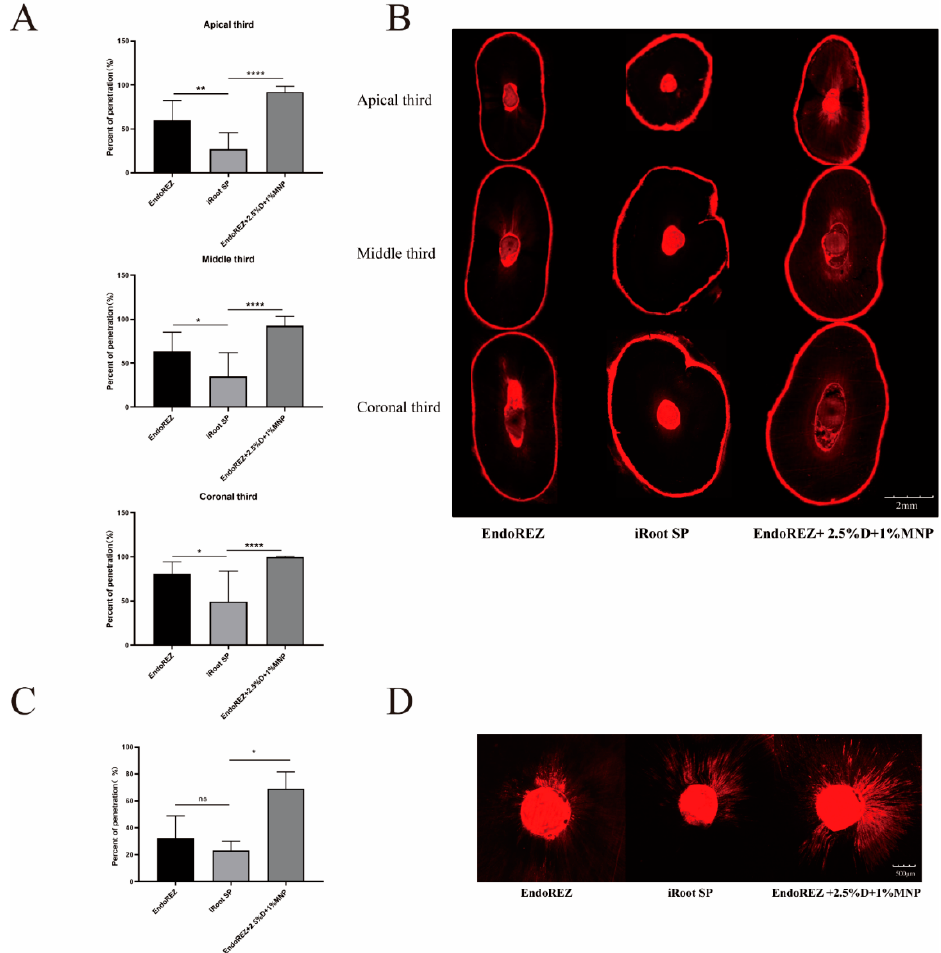
Figure 2. The dentinal tubule penetration of three sealers by CLSM. ( A ) Statistical analysis of dentinal tubule penetration in extracted human single-root maxillary premolars ( n = 10) (dentinal tubule penetration = A/B—A: The portions of the canal circumference in which tubule penetration was seen were measured and added; B: the total circumference of the canal wall). ( B ) Representative images of dentinal tubule penetration in extracted human single-root maxillary premolars (4×). ( C ) Statistical analysis of dentinal tubule penetration in beagle dogs in vivo ( n = 3). ( D ) Representative images of dentinal tubule penetration in beagle dogs in vivo (10 × ). Every value is shown as mean ±